Question: Give a one-sentence summary of this figure.
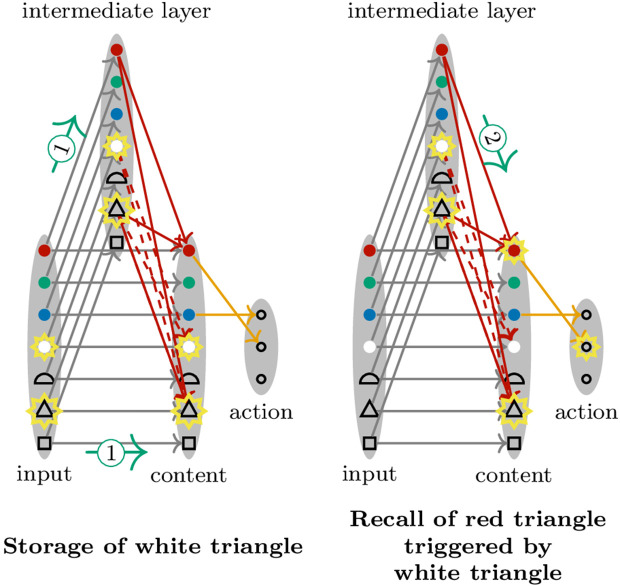
Answer: Example of a Storage and Retrieval Mechanism with Synaptic Delays. Signals take more time to travel in long pathways with multiple intermittent synapses than in short pathways, because signal transmission across chemical synapses takes time. Therefore, multiple pathways of different lengths between two groups of neurons can be used to separate storage and retrieval phases. During storage, the input drives the activity in the intermediate layer; the content layer receives input through the direct “input-content” pathway (indicated by green arrows with label 1). To simplify the exposition, the outgoing connections of the content layer are one-to-one in this example, but the same principle works in less artificial settings with random connectivity (see Fig 7 ). Connections between the intermediate and the content layer (red dashed arrows) are selected for growth with a Hebbian plasticity rule. Shortly thereafter, because of more synaptic delays along the longer pathway, the content neurons receive input through the “input-intermediate-content” pathway, i.e., the intermediate layer is the main input of the content layer (green arrow with label 2). Already grown connections (red arrows) enable recall of previous events. The actual growth of the connections selected in the storage phase (dashed red arrows) is not instantaneous and does therefore not interfere with the recall phase. Once the content neurons received input through the “input-intermediate-content” pathway, the content layer drives the action selection through weights that implement some learned rule (orange arrows).